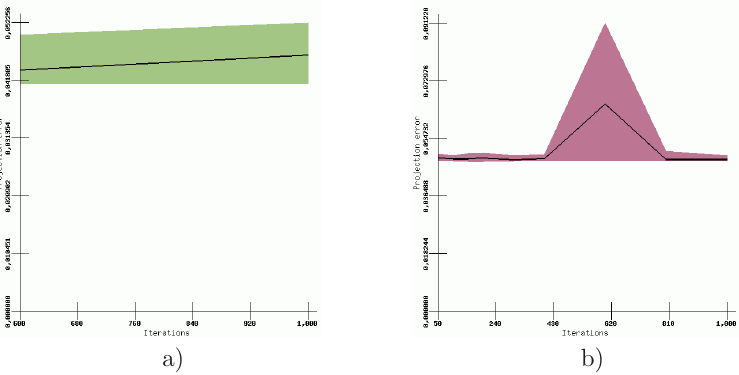
Figure 8. Dependence of the projection error on the iteration number on the basis of the fixed experiments (using Relative MDS, PCA initialization method, 1000 iterations): (a) Ellipsoidal, (b) Sphere data sets.